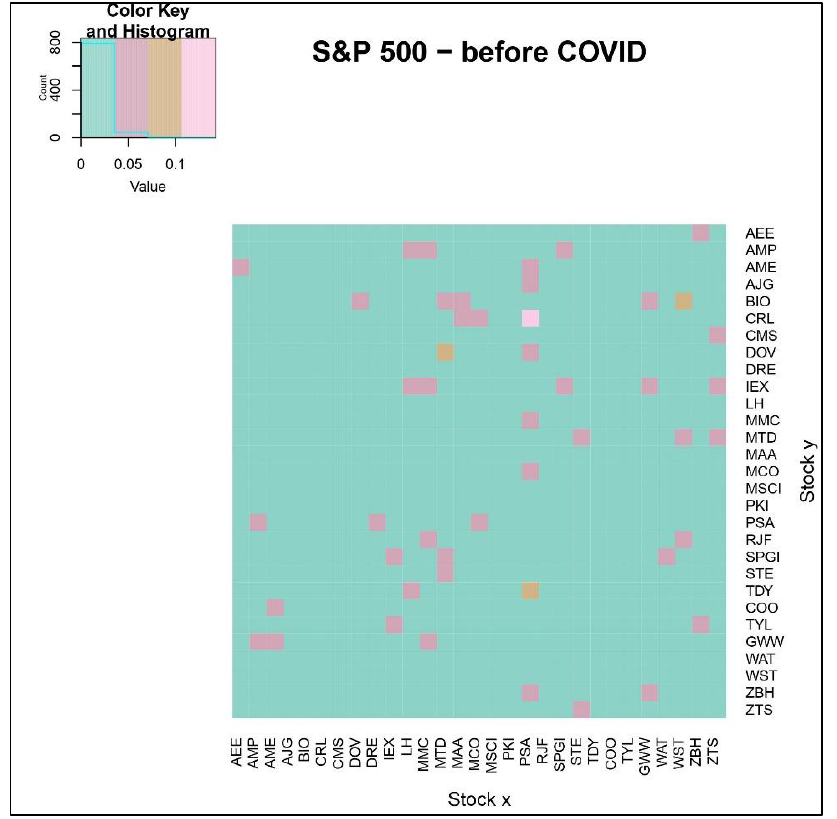
Figure 19. The information flow (effective transfer entropy) from stock y to stock x, for the top companies (by market capitalization) in the S&P500 market, before the COVID-19 outbreak